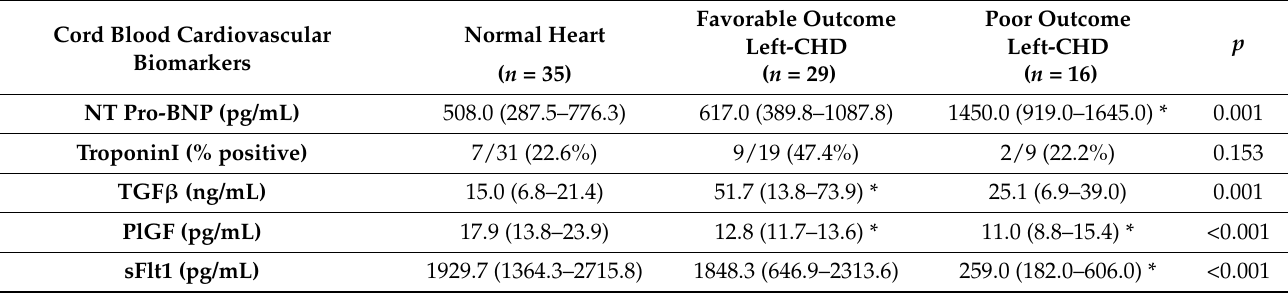
Table 3. Concentrations of N-terminal precursor of B-type natriuretic peptide (NT-Pro-BNP), Troponin I, transforming growth factor β (TGF β ), placental growth factor (PlGF), and soluble fms-like tyrosine kinase-1 (sFlt1) in the cord blood of control fetuses and fetuses with favorable versus poor outcome left congenital heart defects.